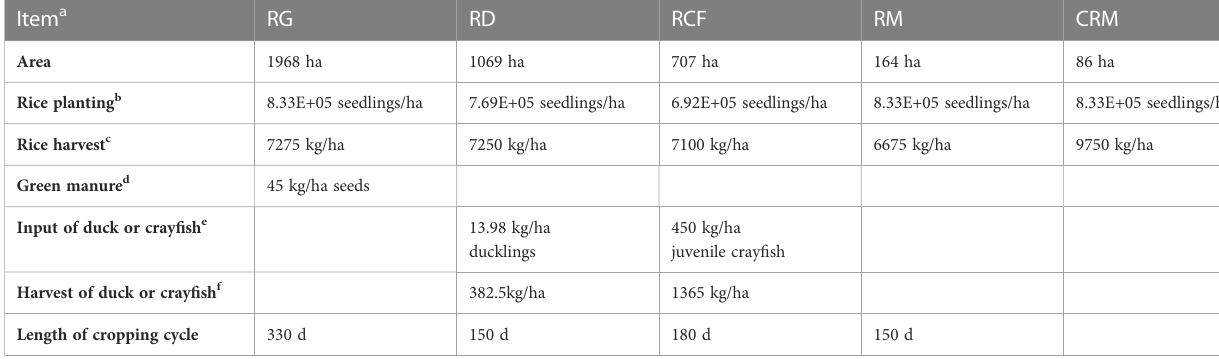
TABLE 1 Characteristics and production processes of the fi ve rice production